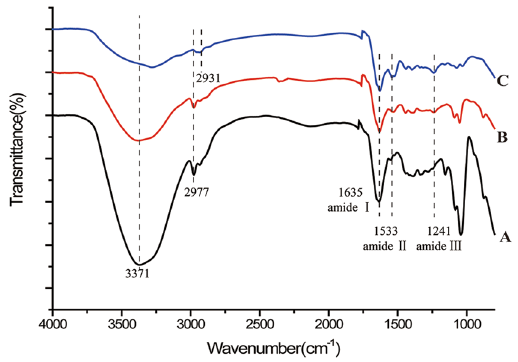
Figure 4. FTIR spectra of ( A ) EM, ( B ) EM/PD and ( C ) EM/AgNPs (n = 3).